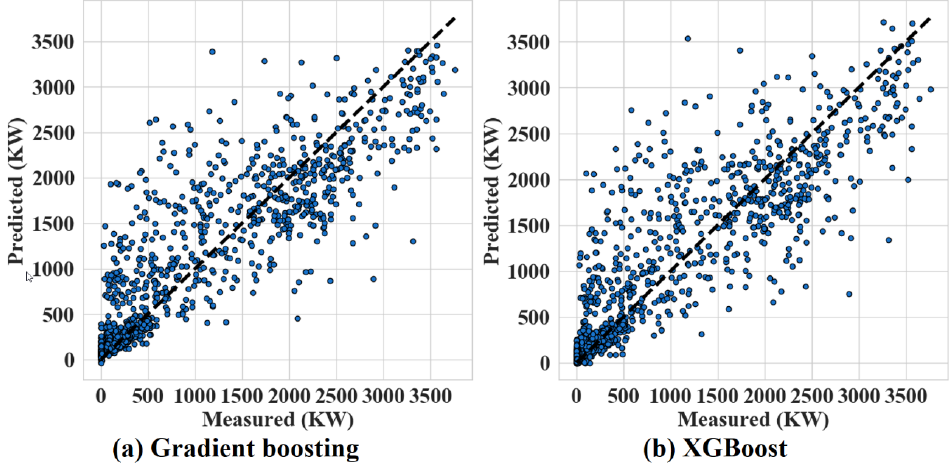
Figure 8. Performances of gradient boosting and XGBoost from 27 May 2015 to 31 December 2015.